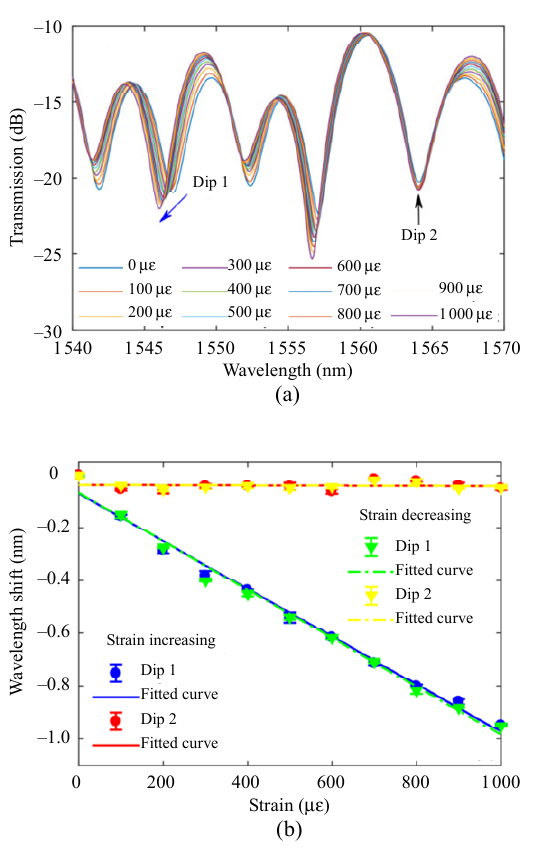
Fig. 5 Strain sensing experimental results: (a) spectrum shift of the sensor in one of the strain increasing tests, and (b) the relationship between the strain and the average wavelength shifts of Dip 1 and Dip 2 in strain increasing and decreasing